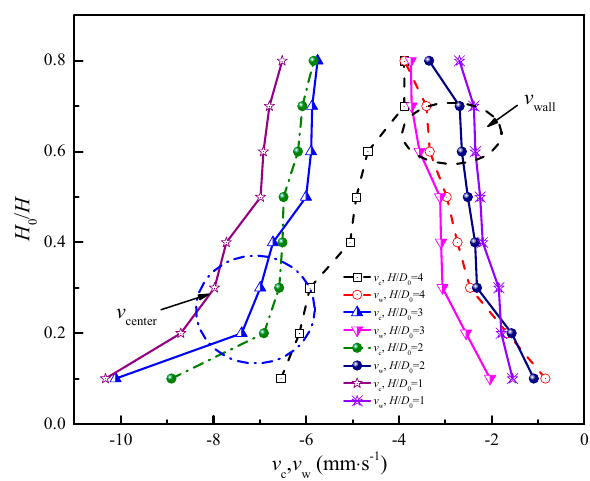
Figure 5. Variation in granular velocity near the wall and in the center of the flow passage with different sinter layers.